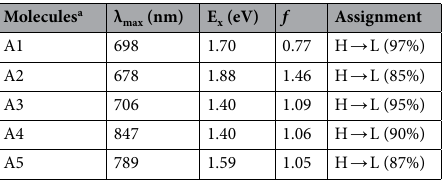
Table 4. The calculated UV results of A1–A5 at TD-DFT/B3LYP 6-31G(d,p) in CHCl 3 . a Values are calculated in CHCl 3 with IEFPCM model.